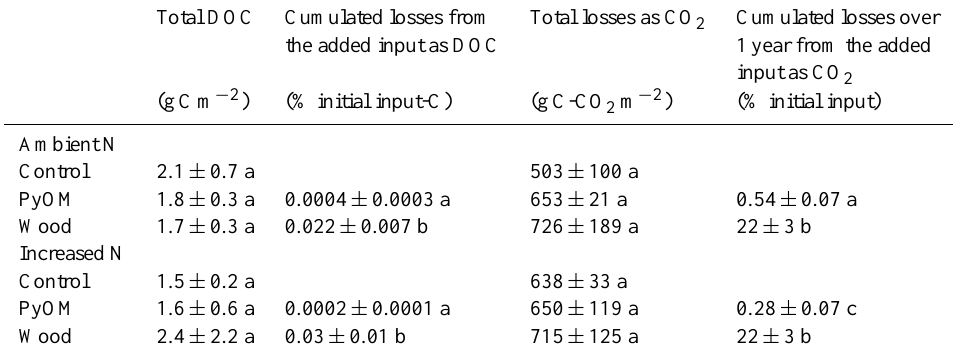
Table 2. Average total C losses over the study period ± standard error ( n = 3). The losses as DOC and DOC from the added inputs correspond to the cumulated losses over a year. The losses as CO 2 and DOC from the added input are calculated using Eq. (3). Letters indicate where treatments are significantly different (pairwise paired t test, p < 0 .